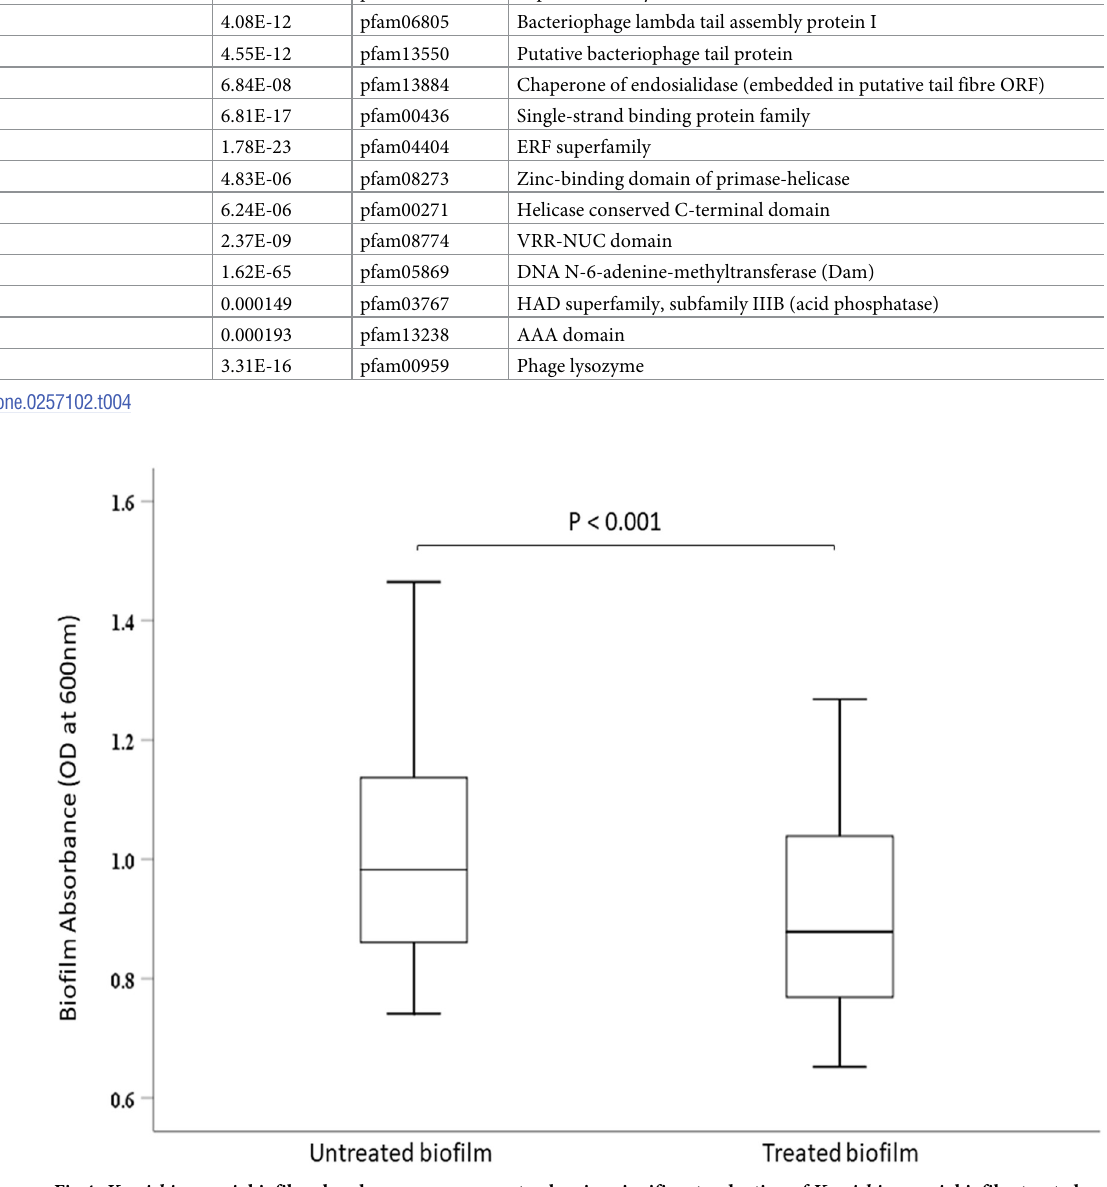
Fig 4. K . michiganensis biofilm absorbance measurements, showing significant reduction of K . michiganensis biofilm treated with KMI8 bacteriophage (p <